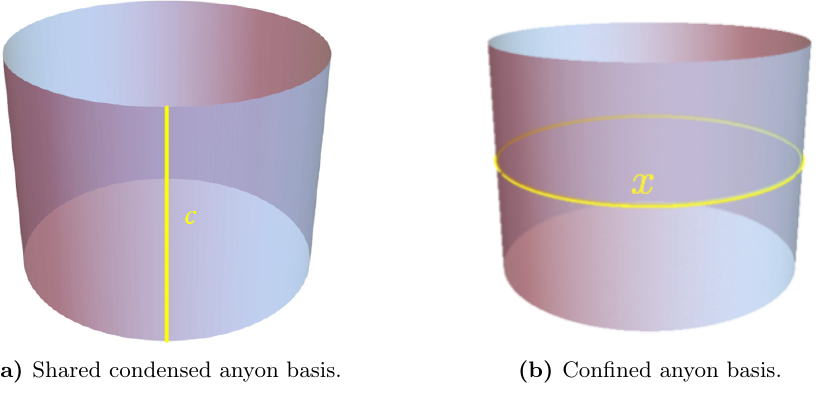
Figure 1 . Ground state basis states on a